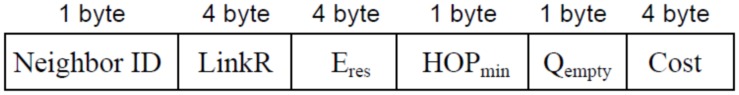
Neighbor table structure.